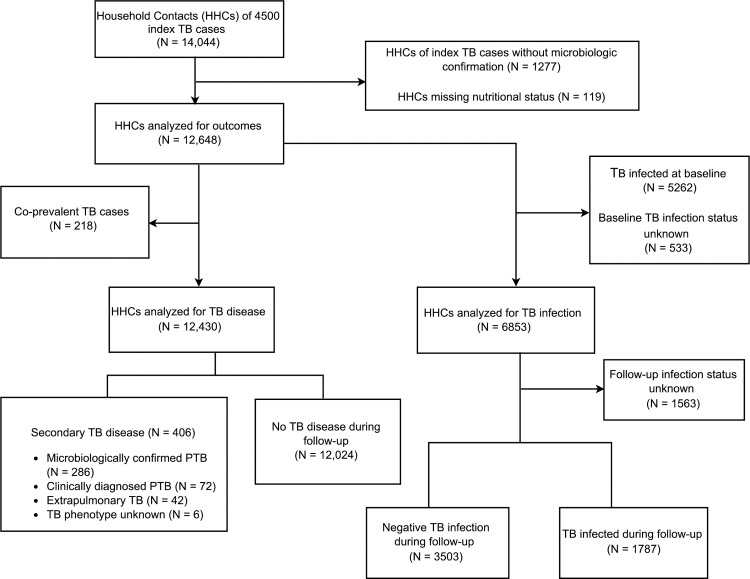
Flow diagram of household contacts of index tuberculosis (TB) cases.